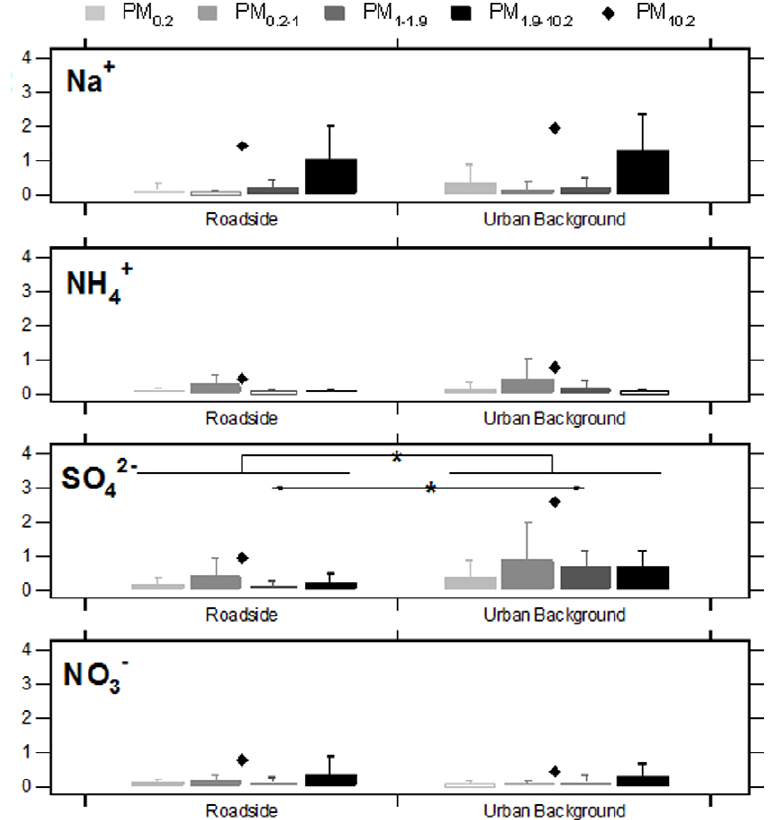
Figure 4. Mean size-fractionated PM soluble inorganic constituent concentrations at primary school grouped by roadside and urban background site types. See the Figure 2 legend for a description of marker and statistical details.